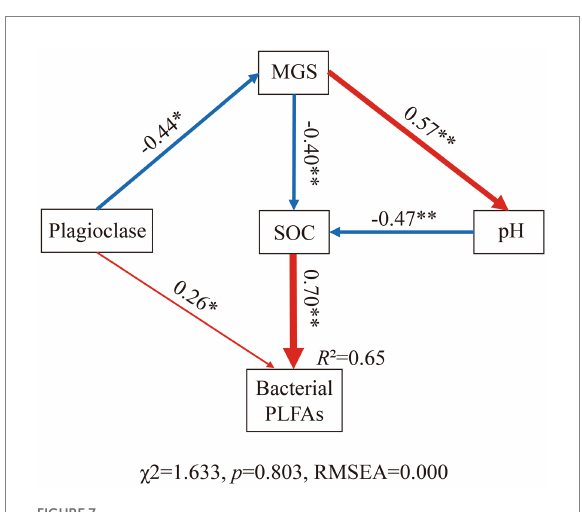
FIGURE 7 Structural equation models (SEM) showing the multivariate effects on soil bacterial PLFA content. Red solid arrows represent positive significant relationships, and blue solid arrows indicate negative significant relationships. The widths of the red and blue arrows are proportional to the strength of the relationship. The numbers adjacent to the arrows are the standardized path coefficients. * p < 0.05, ** p <